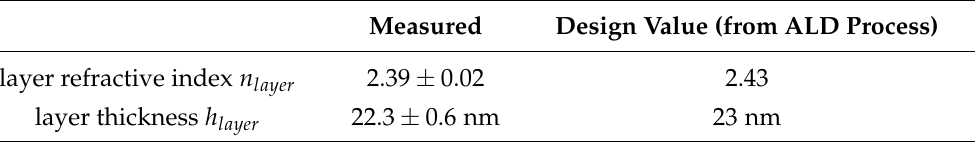
Table 3. Measured layer properties compared to the target values of the ALD process. The uncertain- ties of the target values are